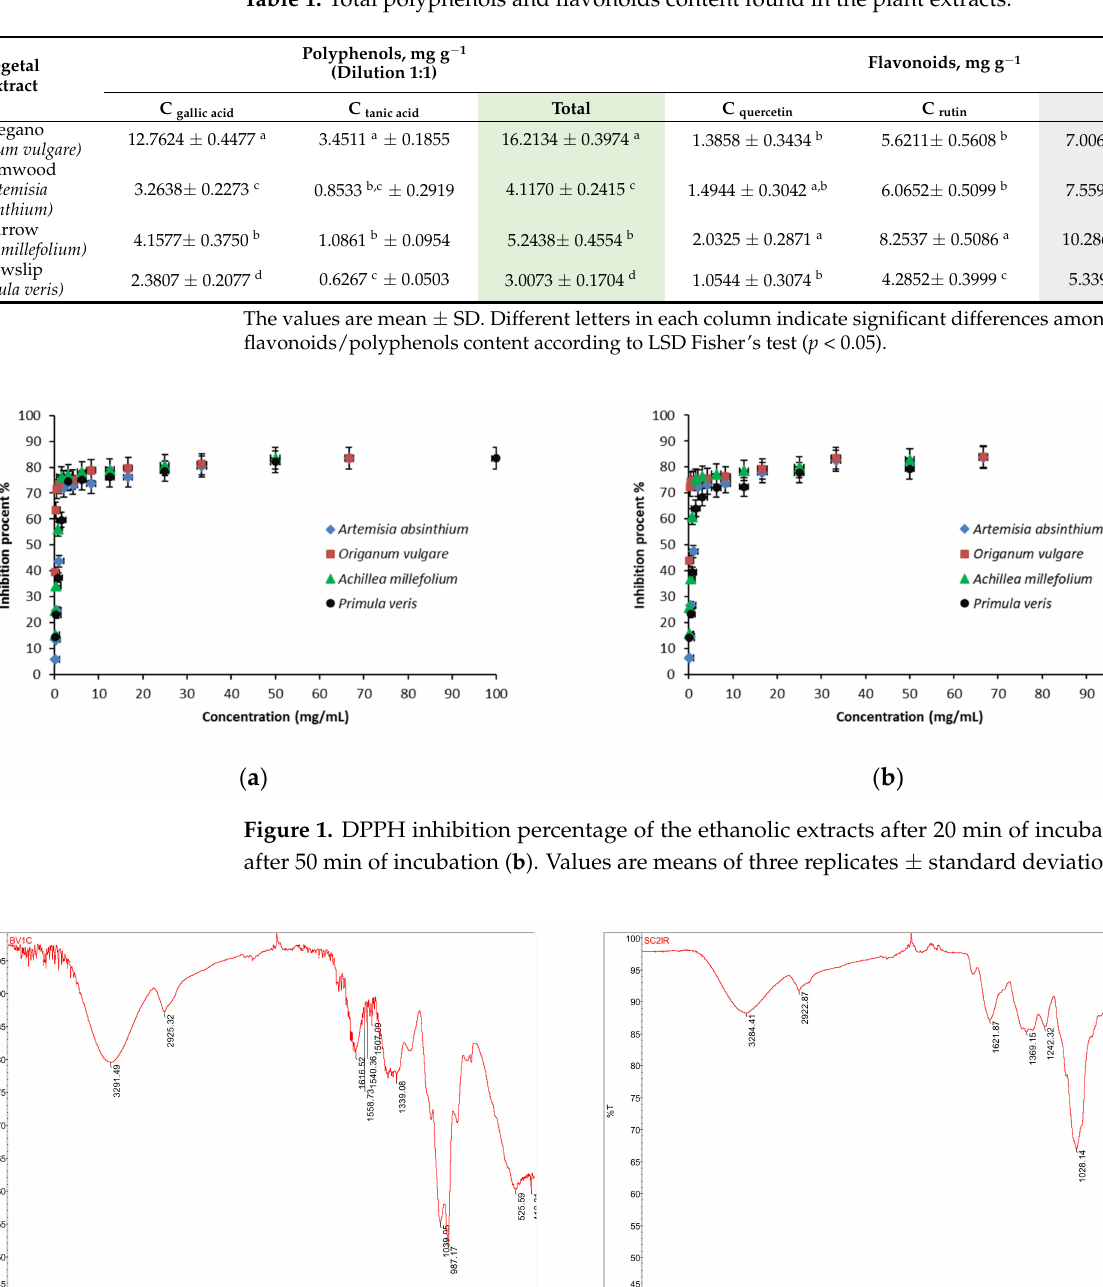
Table 1. Total polyphenols and flavonoids content found in the plant extracts.